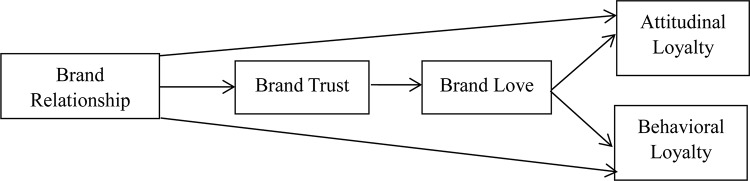
Research framework.